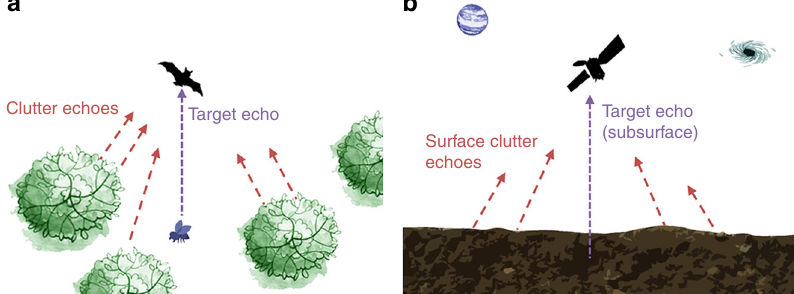
Fig. 3 Bats and radar sounder similarity in acquisition geometry. Similarity between a bats and b radar sounders acquisition geometry. In the bat case, side clutter echoes are coming from foliage, while in the radar sounder case are coming from surface features. For both cases, the target of interested is always